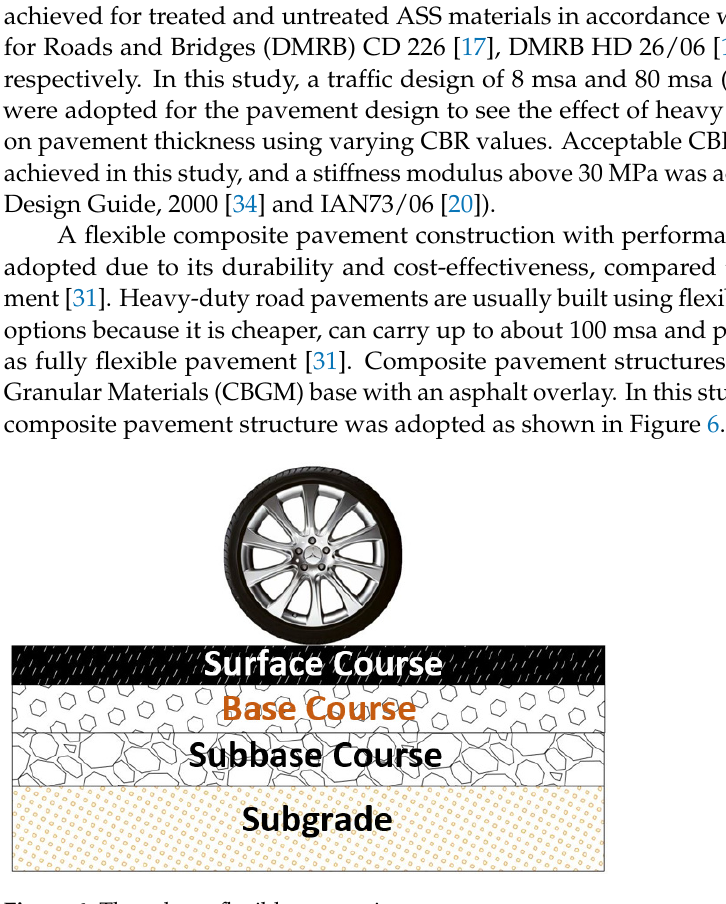
Figure 6. Three-layer flexible composite pavement structure.